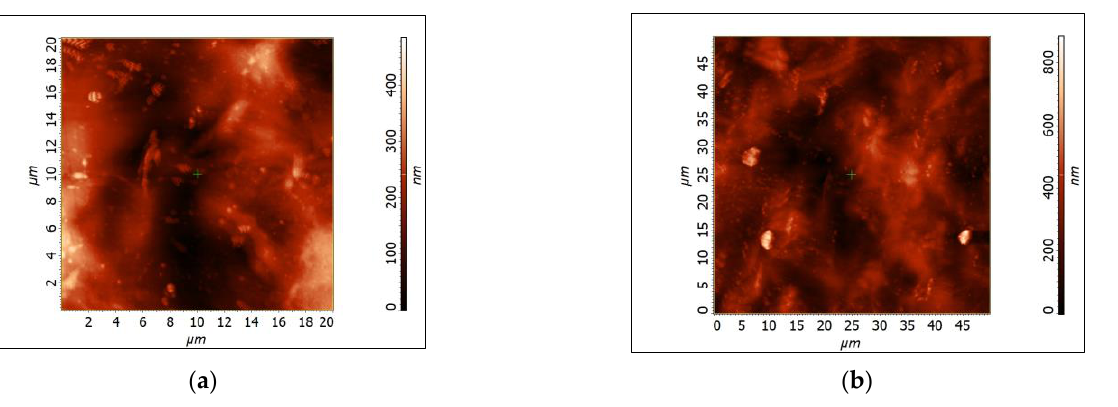
Figure 8. AFM 2D images of the hydrolyzed corn starch films: ( a ) 20 × 20 µm 2 ; ( b ) 50 × 50 µm 2 .